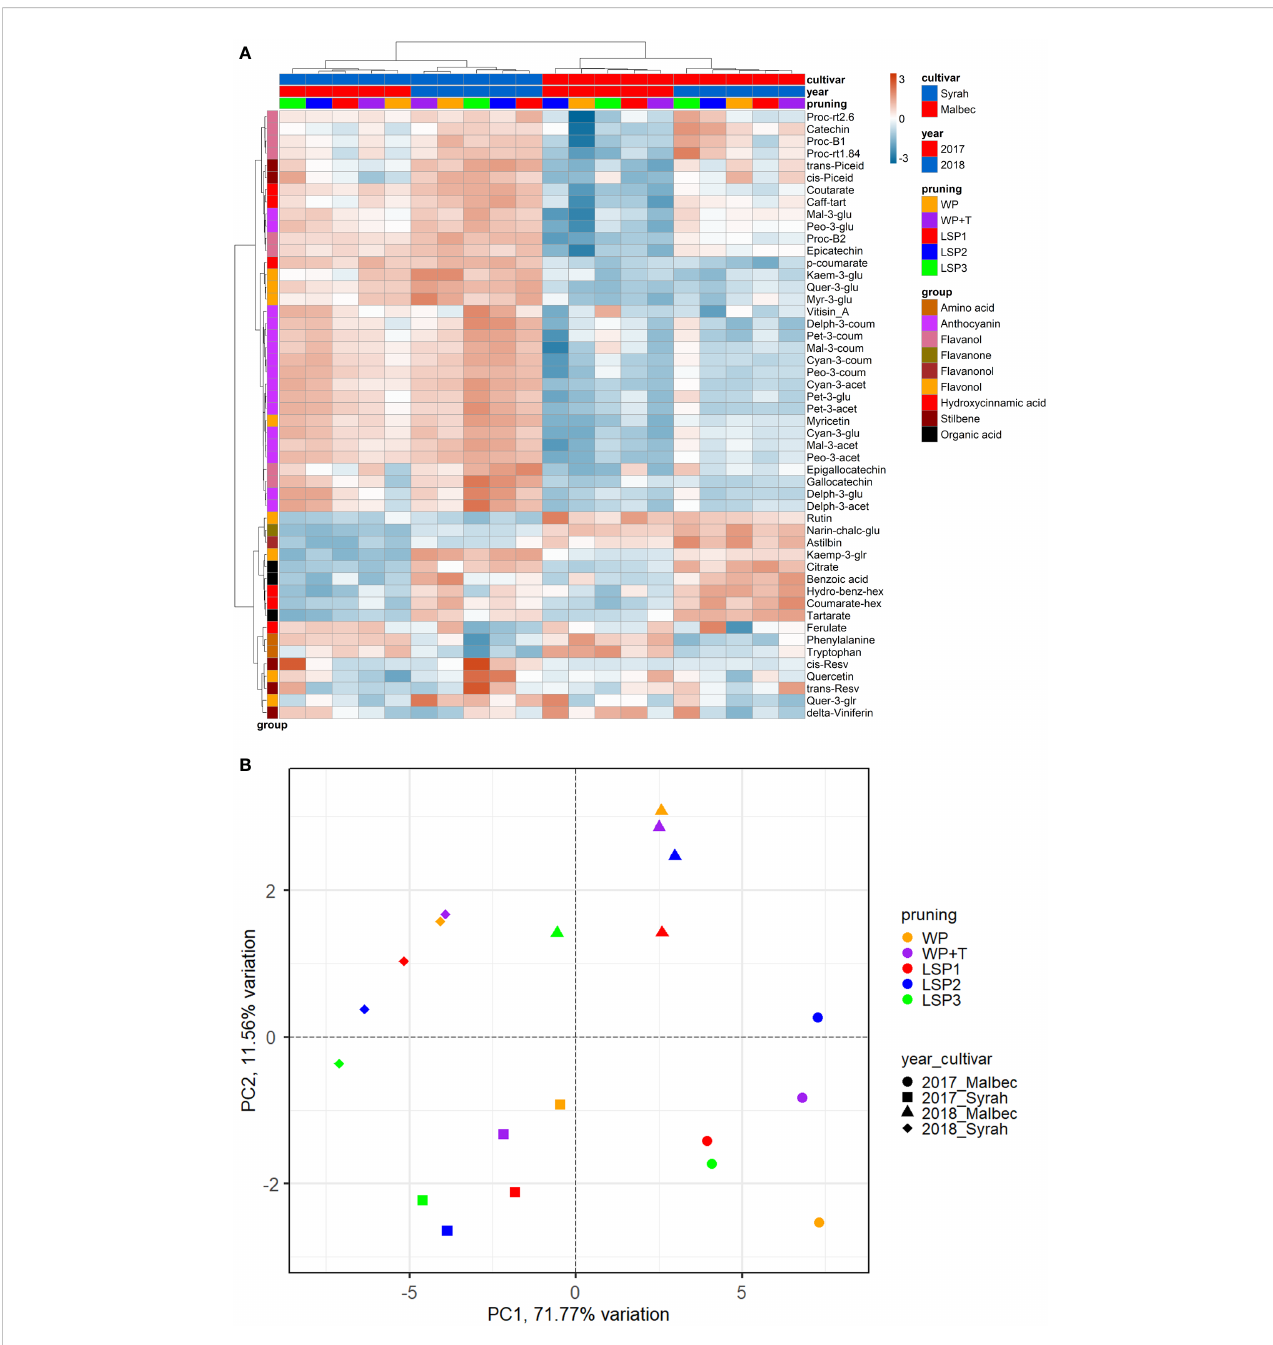
FIGURE 2 Heatmap and 2D PCA score plot of annotated LC-MS based metabolites in must Samples. (A) Hierarchical clustering heatmap obtained from the cluster analysis sharply divided the samples into cultivar and year and pruning. (B) PCA score plot from metabolite data including cultivar and year and pruning treatments. Samples from the most extreme late shoot pruning treatments ( “ LSP3 ” and “ LSP2 ” ) and samples from the no-late pruning treatments ( “ WP+T ” and “ WP ” ) seemed to form two different groups. The late shoot pruning treatment “ LSP2 ” alternatively clustered with one of the two